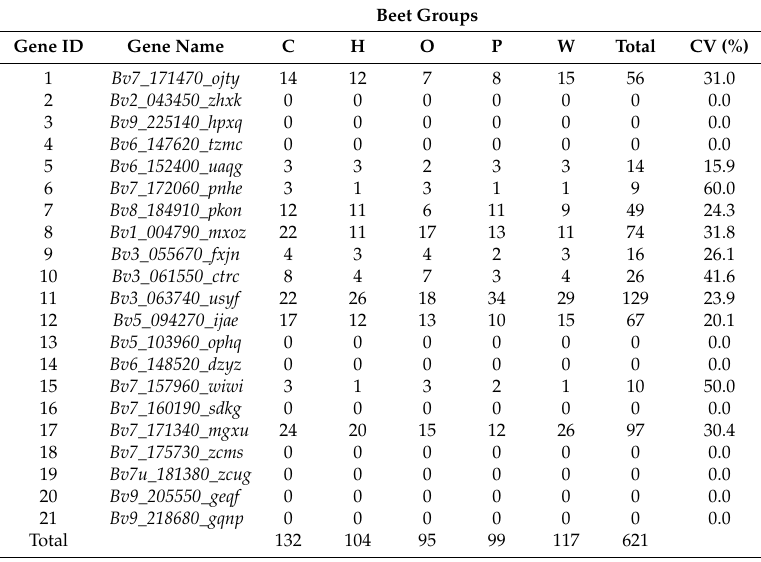
Table 4. The number of SNPs of RGAs per individual in five beet groups. Beet